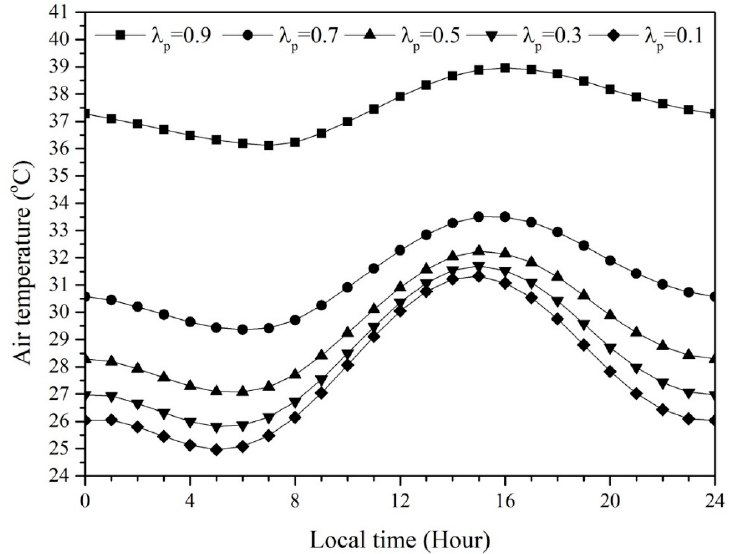
Figure 14. The air temperature at 16 September 2012 when p  (plan area ratio) is